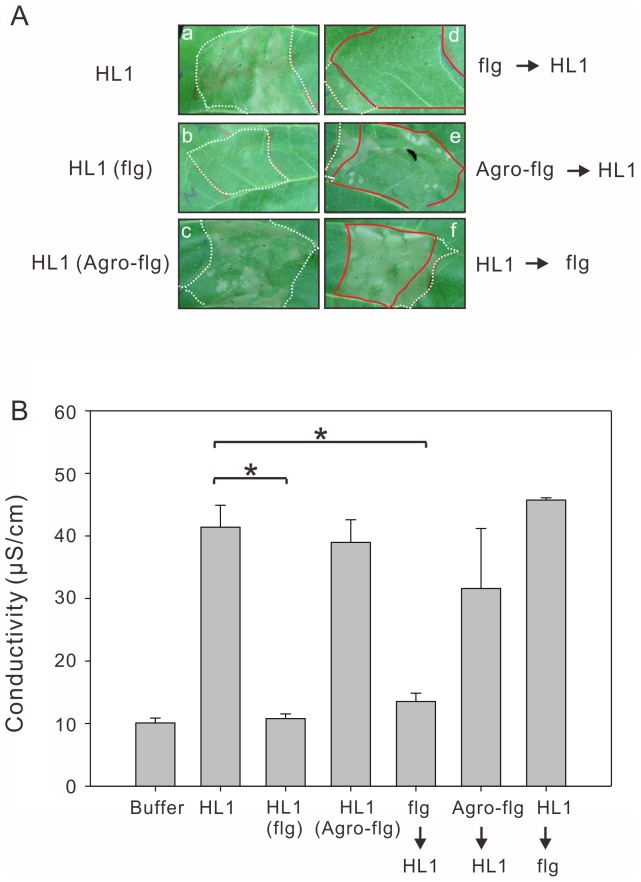
Pre-treatment of flagellin from PA5, but not A. tumefaciens (Agro) can impair the HR.(A) 0.8 µM of flagellin from PA5 or Agro was infiltrated simultaneously [indicated as HL1 (flg) and HL1 (Agro-flg), respectively] with 5×106 cfu/ml of HL1 (a, b, c). 6 h prior inoculation with 0.8 µM of flagellins, the leaves were then challenged the HR elicitation by 5×106 cfu/ml of HL1 (d, e). 6 h prior inoculation with 5×106 cfu/ml of HL1, the leaf was infiltrated with 0.8 µM of flagellin (f). The white dotted lines indicate the area infiltrated with HL1 and the red lines indicate the overlapped area infiltrated with HL1 and flagellins. The photos were taken 48 h after inoculation. (B) Electrolyte leakage from leaf areas inoculated with indicated inoculums. The conductivity values represent the mean and standard error of three different leaves. Significant differences (p<0.05) were indicated by asterisk (*). All experiments were repeated at least three times with similar results.